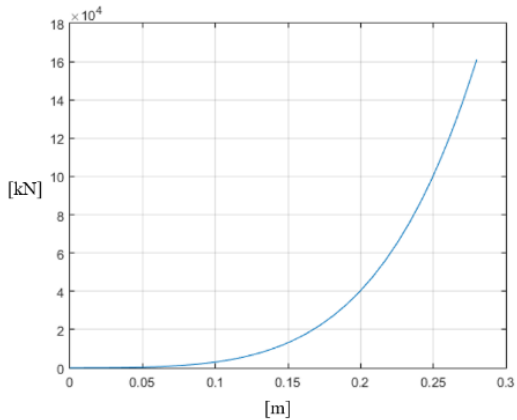
. (cid:0) (cid:1) x , x at an operating temperature of +15 ◦ C and η CT = 0.4. Figure 9. Change of dynamic force 𝐹(𝑥,𝑥̇) at an operating temperature of +15 °C and 𝜂 𝐶𝑇 = 0.4 .